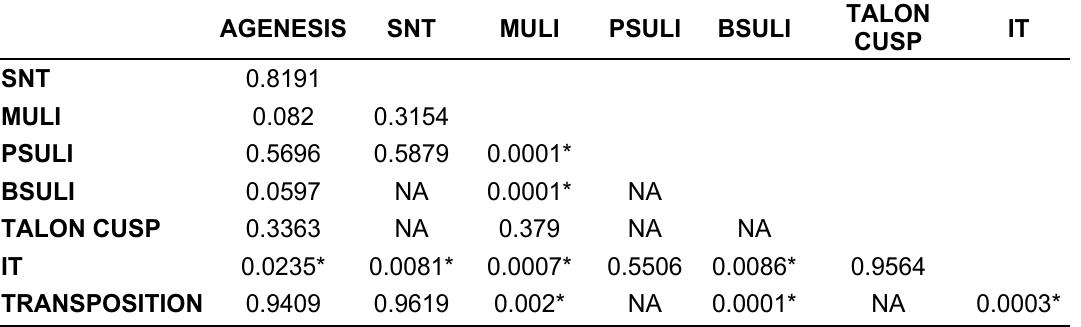
Table 2. Associa.ons between dental anomalies calculated by Chi -­‐ squared and Fisher exact